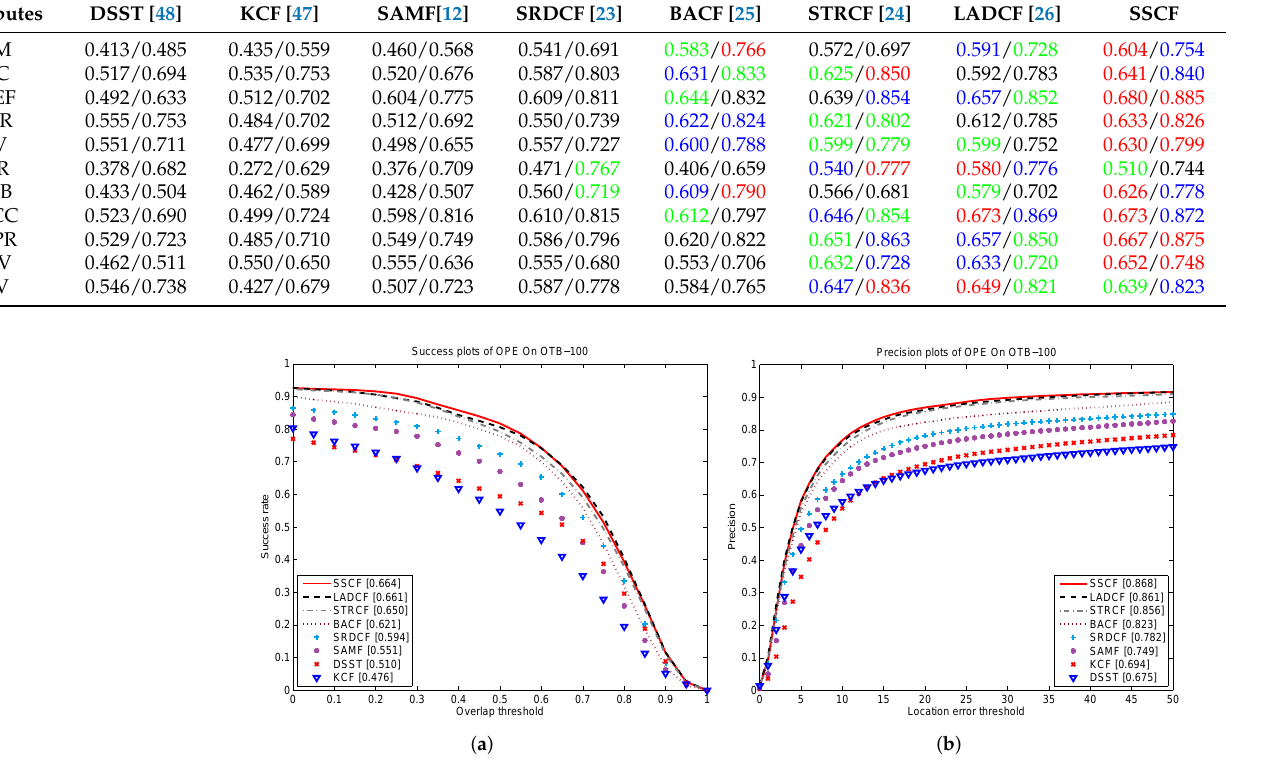
Figure 2. Success plots ( a ) and precision plots ( b ) of the proposed SSCF and the other trackers on the OTB100 database. Table 2. The area under the curve (AUC) and distance precision (DP) scores of the proposed SSCF and the other trackers on different attributes on the OTB100 database. The top-three methods on each attribute are denoted by different colors: red, blue, and green. That is, red represents the best performance, blue represents the second best, and green represents the third best